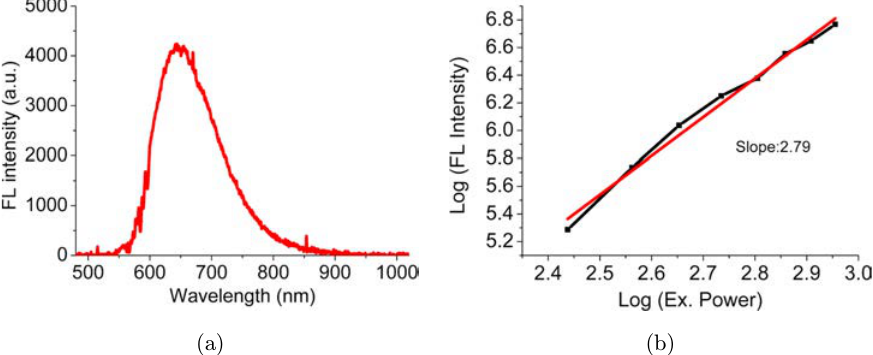
Fig. 4. (a) Nonlinear response of DCDPP-2TPA NPs solution under 1550 nm fs laser excitation. (b) Power dependence rela- tionship of 3PF signal from DCDPP-2TPA NPs.